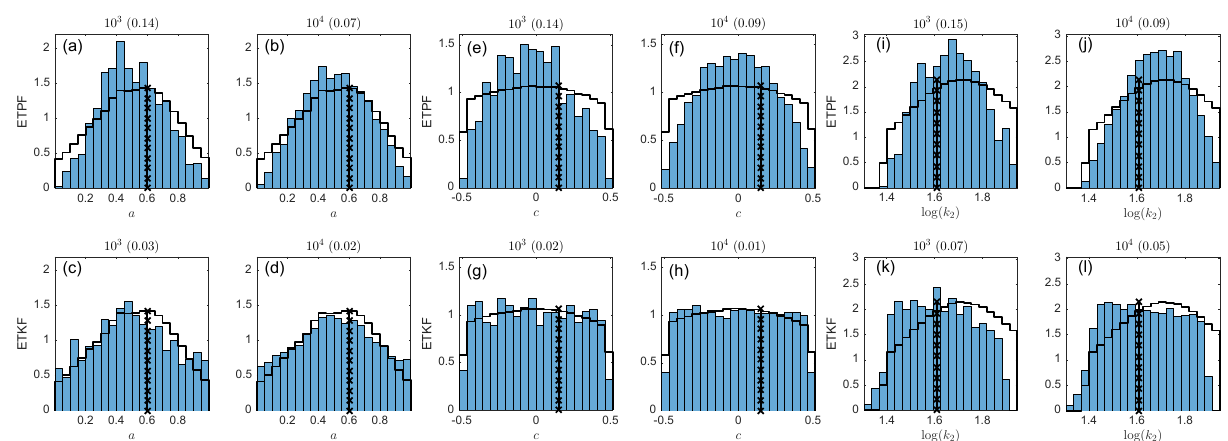
Figure 3. Probability density functions for the parameters a (a–d) , c (e–h) , and log (k 2 ) (i–l) . The posterior obtained by IS with ensemble size 10 6 is plotted as a black line and the true values of parameters are plotted as black crosses. The posterior of ETPF is shown at the top and the posterior of ETKF at the bottom. ETPF and ETKF used 10 3 (odd columns) and 10 4 (even columns) ensemble members.